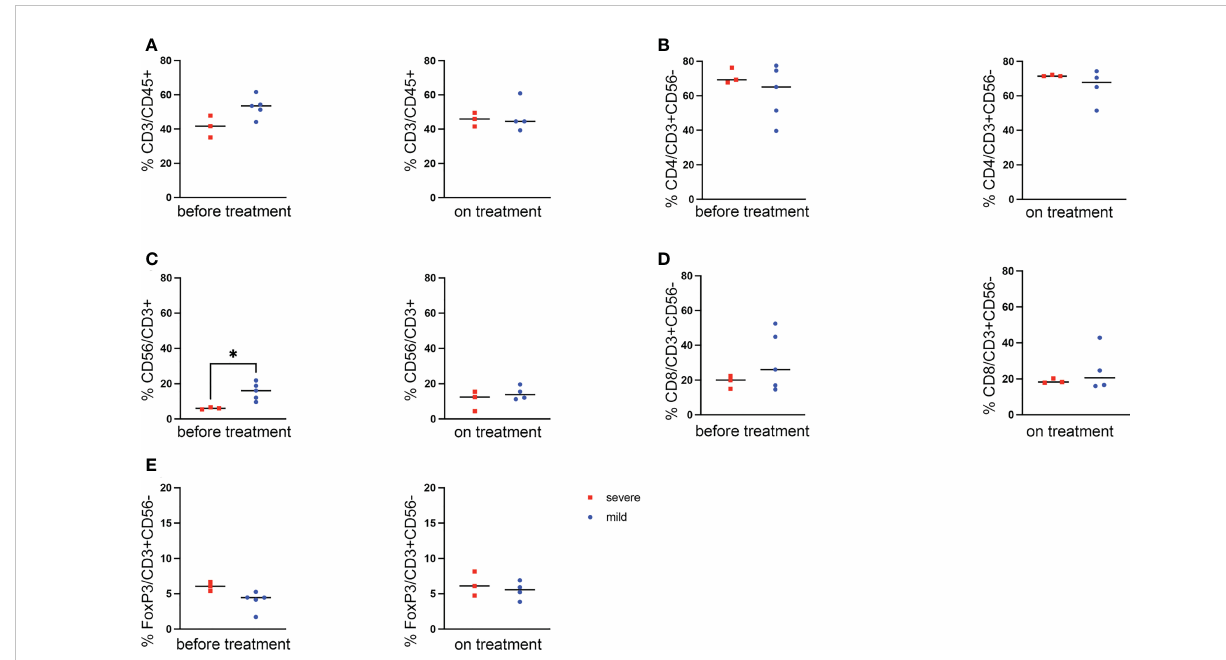
FIGURE 1 Changes of lymphocyte populations in patients treated with PD-1 monoblockade. (A) Comparison of mean percentage of CD3 + cells in lymphocytes between the two patient groups of cohort 1 (severe vs mild) on timepoint one and timepoint two (before treatment and 4-6 weeks after start). (B – D) CD4 + (B) , CD56 + (C) and CD8 + T cells (D) at different time points compared between patients developing severe irAEs and patients with only mild side effect. (E) Frequency of FoxP3 + regulatory T cells in the two groups of patients. Statistical analysis was performed by a T test. *